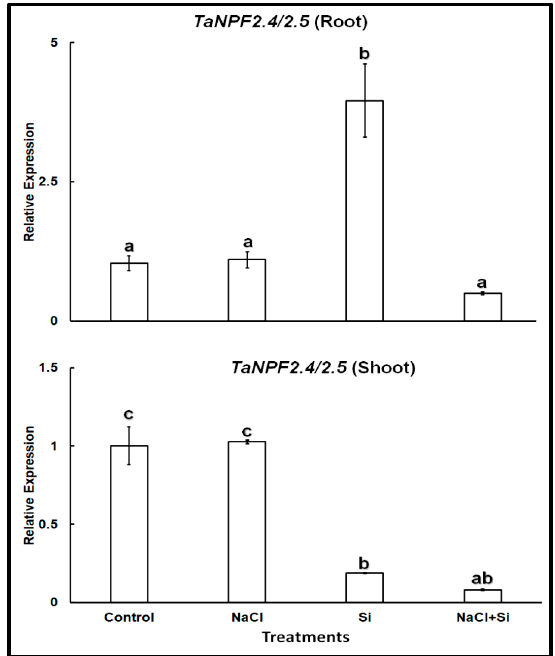
levels in both roots and shoots.